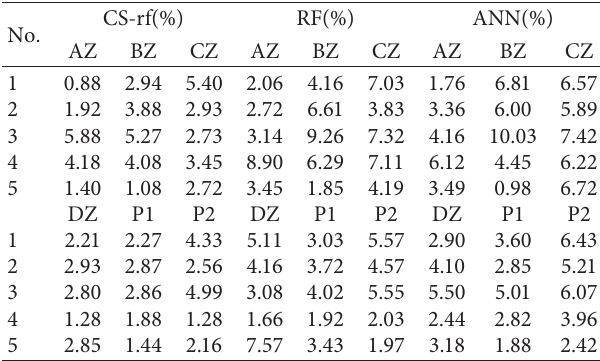
Figure 8: Plastic zone under different excavation footage. Table 6: Comparison of prediction